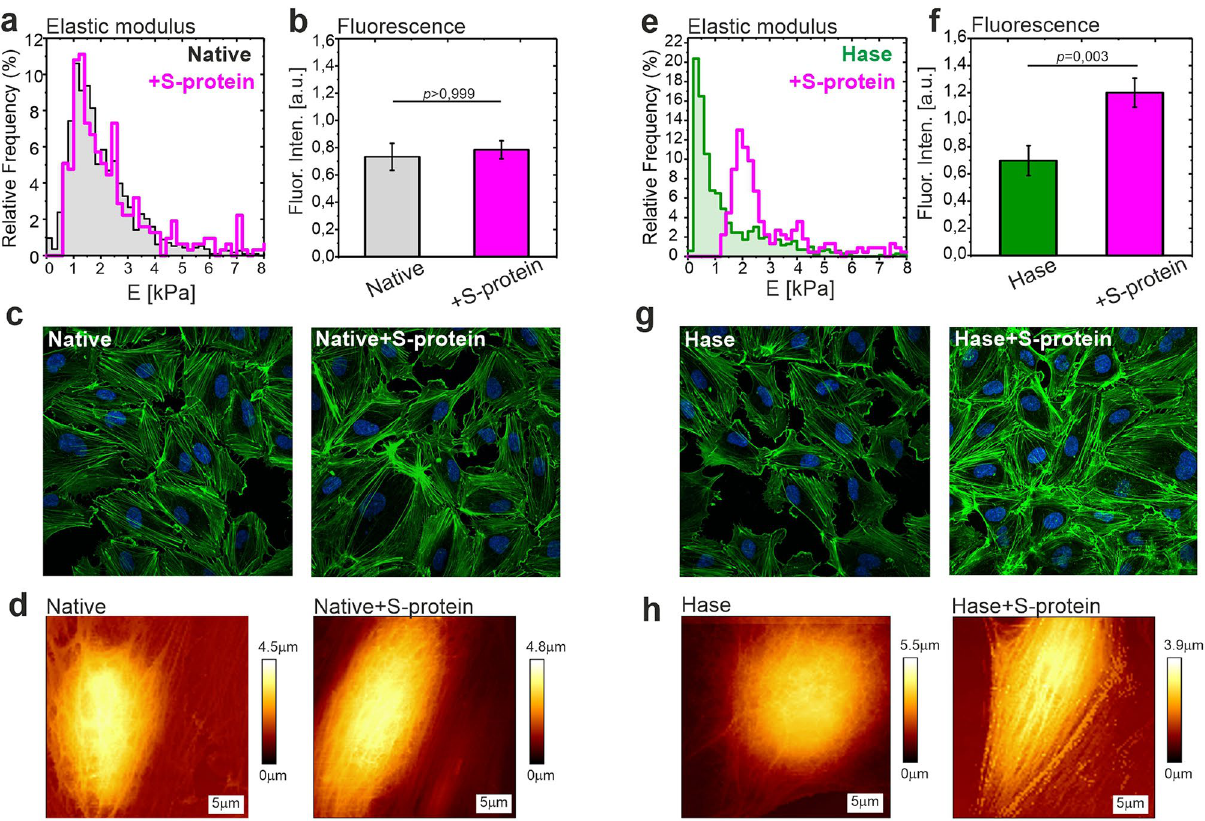
Figure 5. Endothelial cells stiffening after incubation with S-protein is more pronounced for cells with removed glycocalyx. ( a ) Elastic modulus of HPAECs for native cells (grey histogram) and for cells incubated with S-protein (magenta). ( b ) Mean fluorescence intensity of phalloidin (AlexaFluor488). ( c ) Examples of fluorescence images depict the actin structure in native HPAECs and after incubation with S-protein. Green— actin. Blue—nucleus. ( d ) Examples of AFM-QI images of native HPAECs and after incubation with S-protein. ( e ) Elastic modulus obtained for HPAECs pre-incubated with heparinase (green) and next incubated with S-protein (magenta). ( f ) Mean fluorescence intensity of phalloidin (AlexaFluor488) after removal of HS. ( g ) Fluorescence images show the actin polymerization that occurred after incubation with S-protein for HPAECs pre-incubated with heparinase. ( h ) Examples of AFM-QI images depict the changes of cell morphology and cortical actin network after incubation with S-protein for HPAECs pre-incubated with heparinase. Statistics: p values were determined by one-way ANOVA followed by Tukey’s post-hoc test. Figure created with OriginPro2021 (https:// www. origi nlab. com/ 2021), ImageJ 1.53e (https:// imagej. nih. gov/ ij/) and JPK Data Processing 6.1.79 (https:// www. jpk.